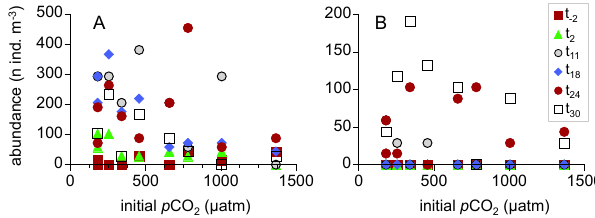
Fig. 7. Abundances of larvae of bivalves (A) and gastropods (B) on the different sampling days in the water column in relation to initial CO 2 concentrations (µatm) in the mesocosms after the CO 2 manipulation was completed. Please note that the scales of (A) and (B) are